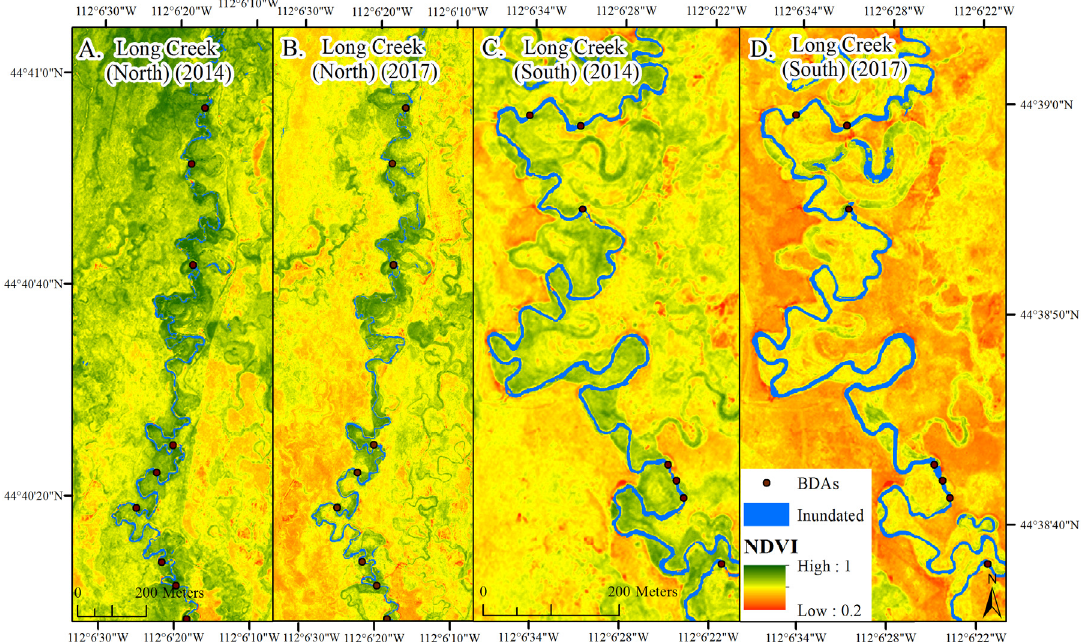
Figure 11. Change in riparian greenness along ( A ) Long Creek (North, 2014), ( B ) Long Creek (North, 2017), ( C ) Long Creek (South, 2014), and ( D ) Long Creek (South, 2017) from pre- to post-restoration conditions. NDVI: Normalized difference vegetation index; BDAs: beaver dam analogues.